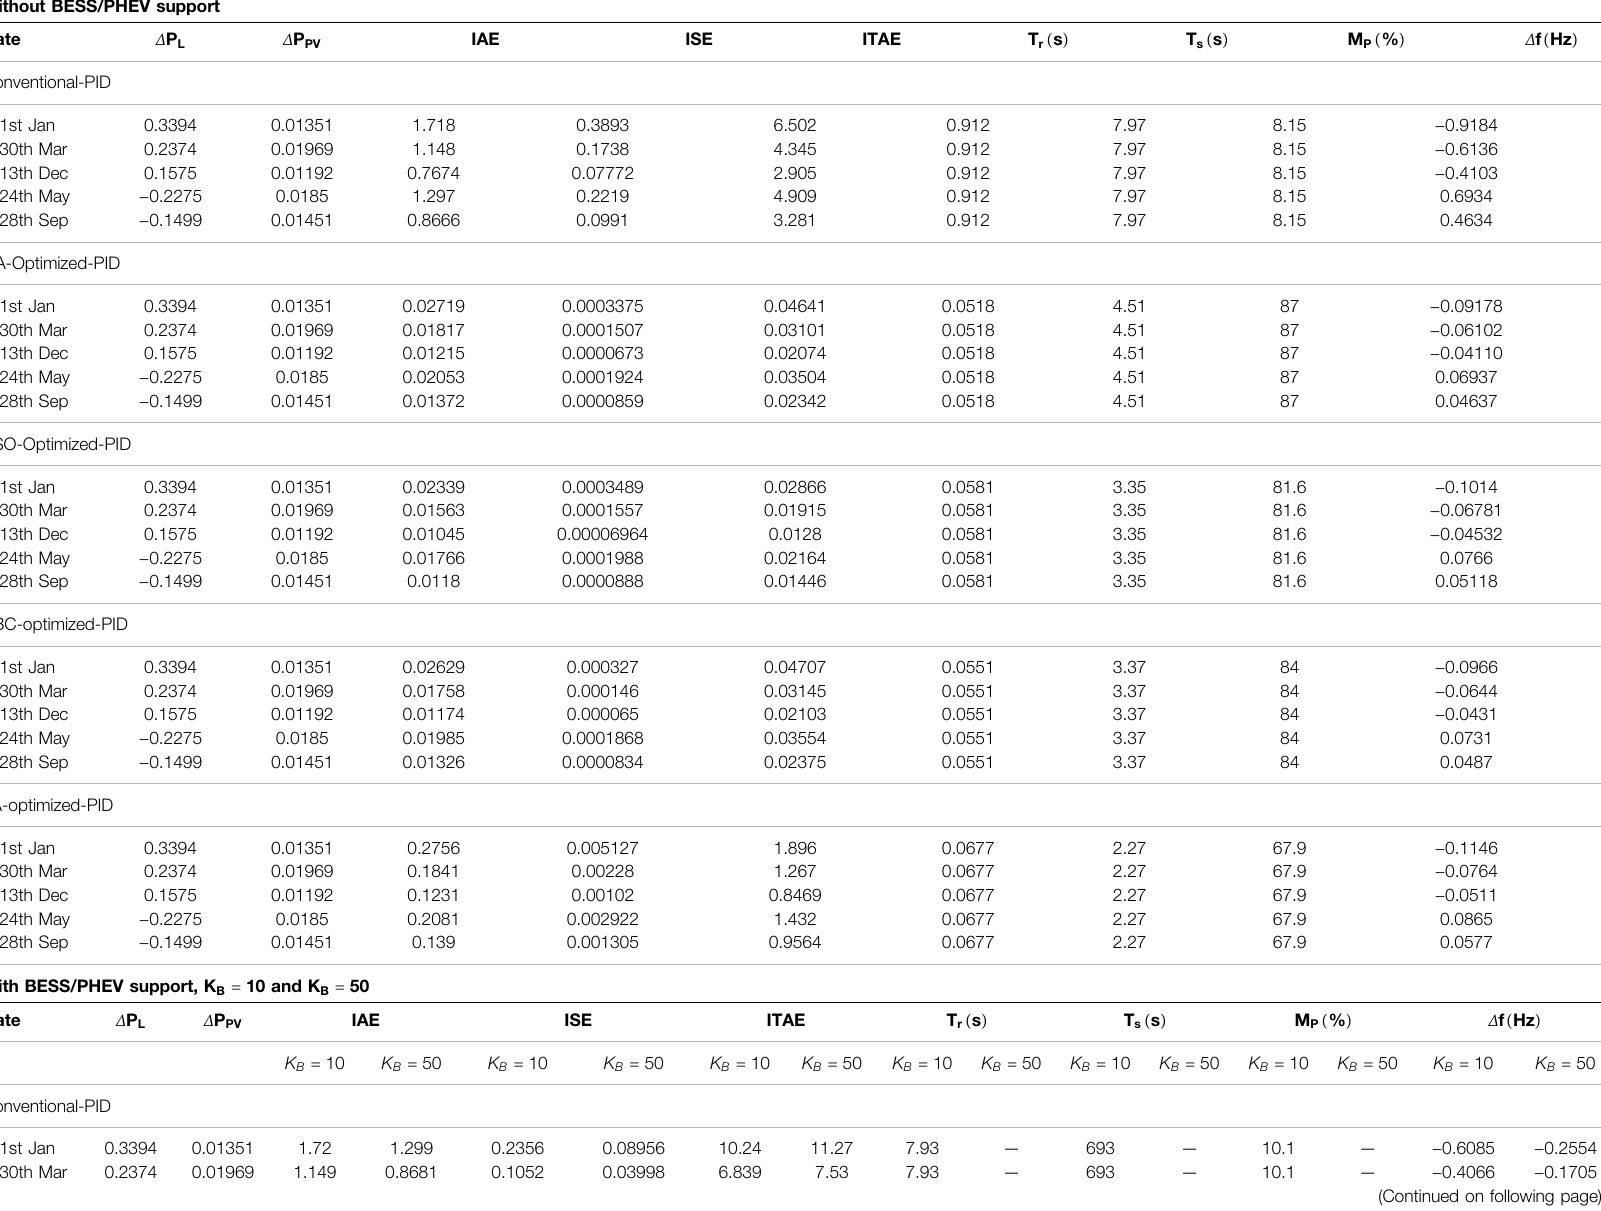
TABLE 7 | Frequency deviation parameter indices using integral square error objective